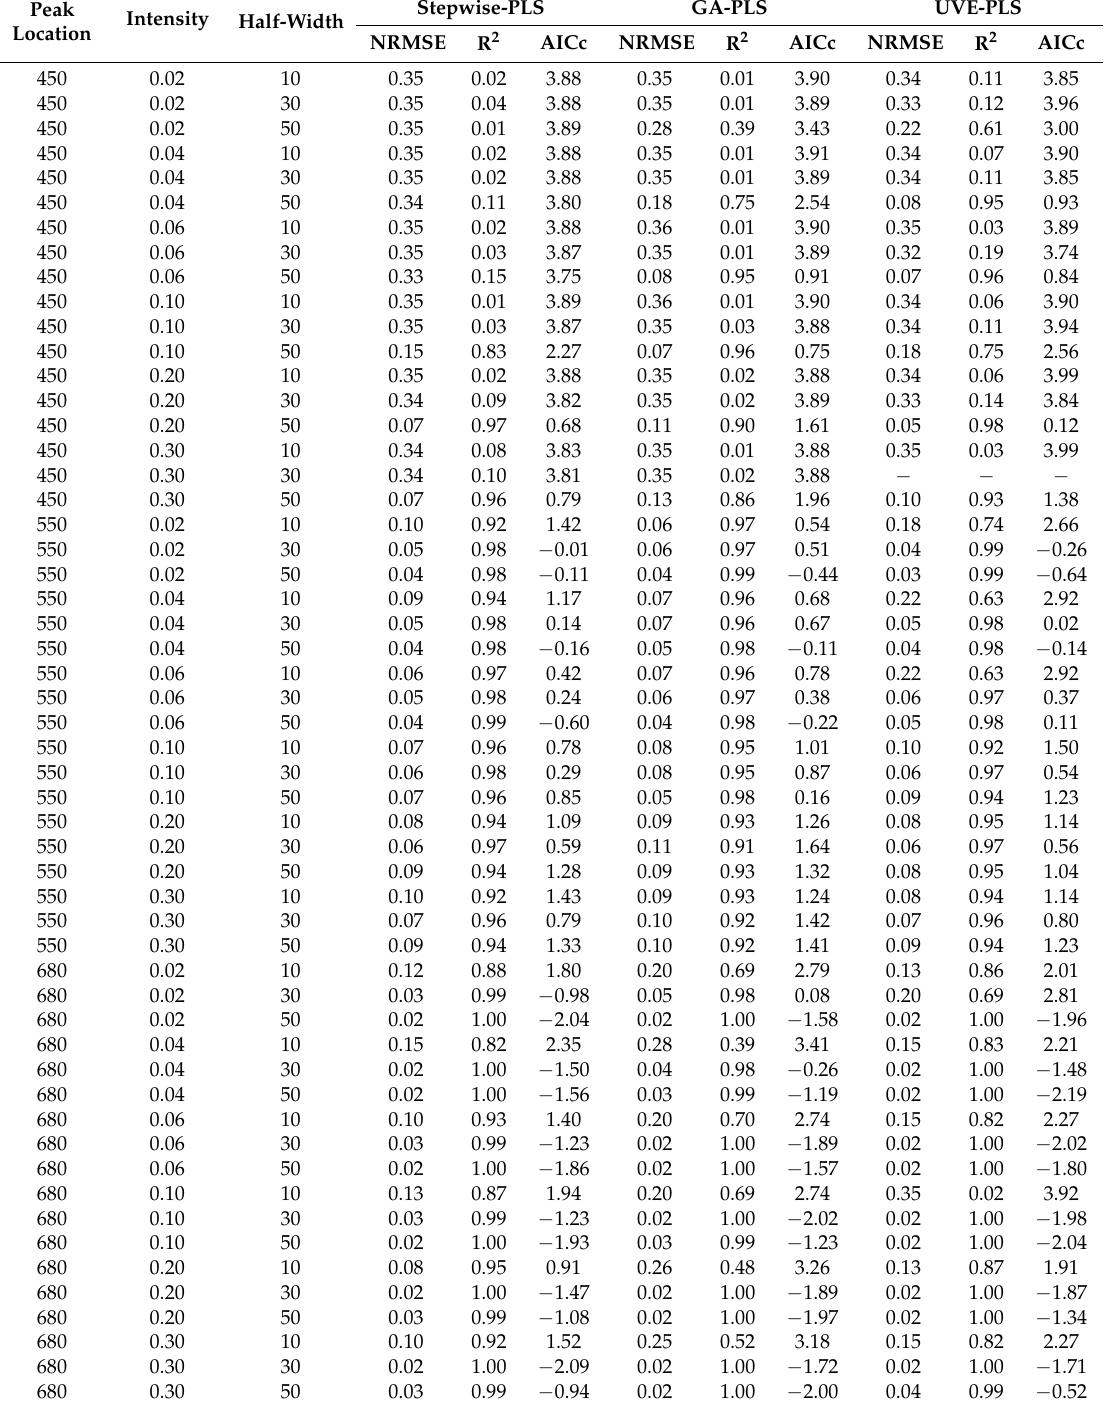
Table 1. Descriptive statistics of the performance of PLSR models calibrated for estimation of C d with different absorption peak locations, intensities, and